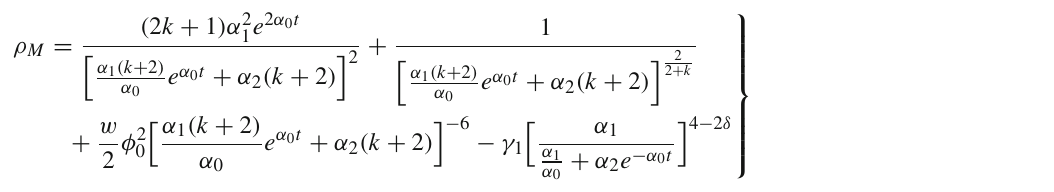
M ) of DM versus time ( t ) for k α = 1 . 2, α = 0 . 52, and γ = 1 2 1